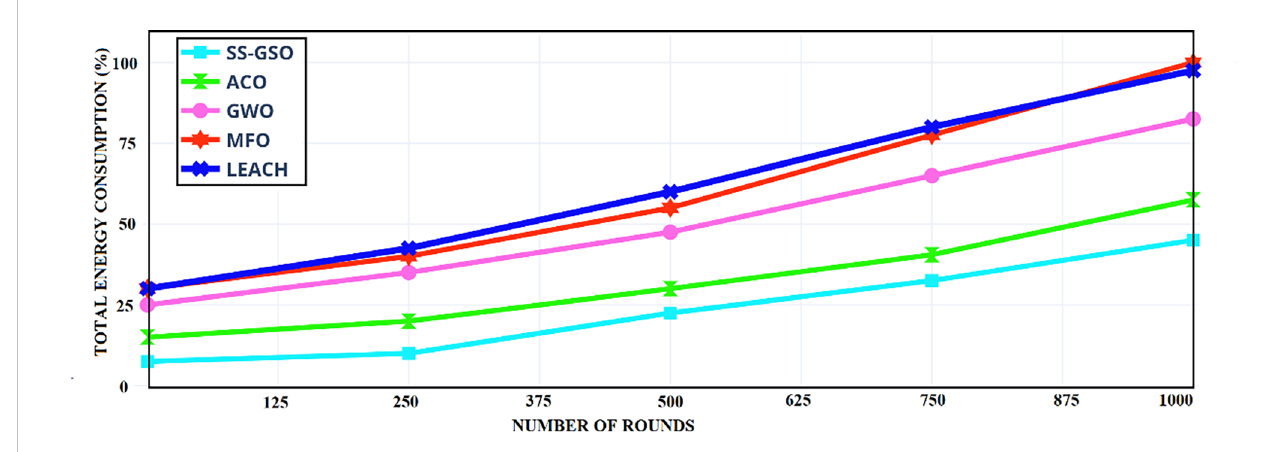
FIGURE 7 Total energy consumption by